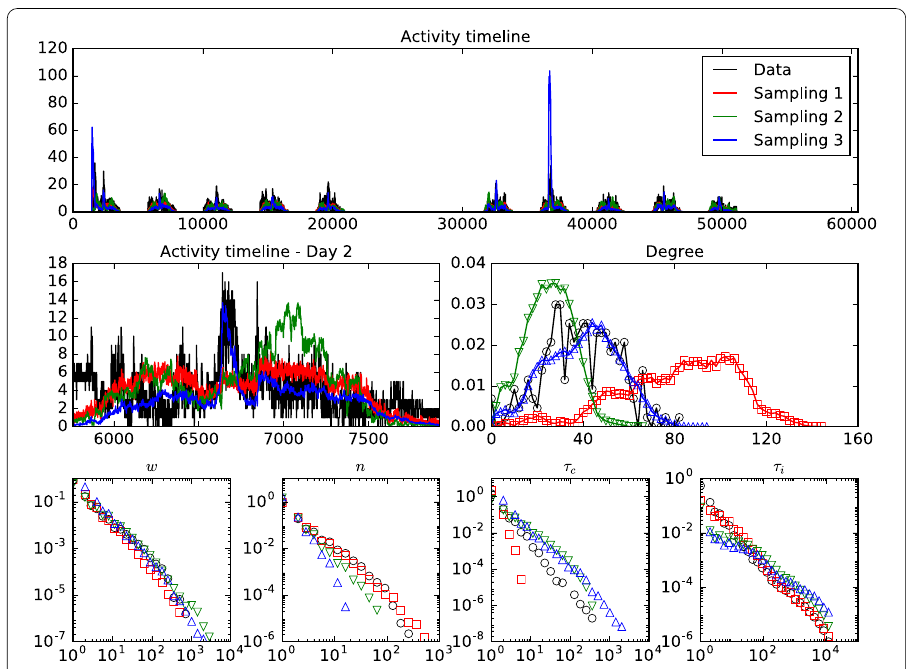
Figure 5 Properties of the sampled co-presence networks—InVS15. We compare several properties of the contact network from the original data set with the surrogate contacts obtained by sampling of the co-presence data: overall timeline of contact activity, distributions of degree, weight w and number of contacts per link n in the network aggregated over the whole data collection period, and distributions of the contact duration τ c and inter-contact duration τ i .